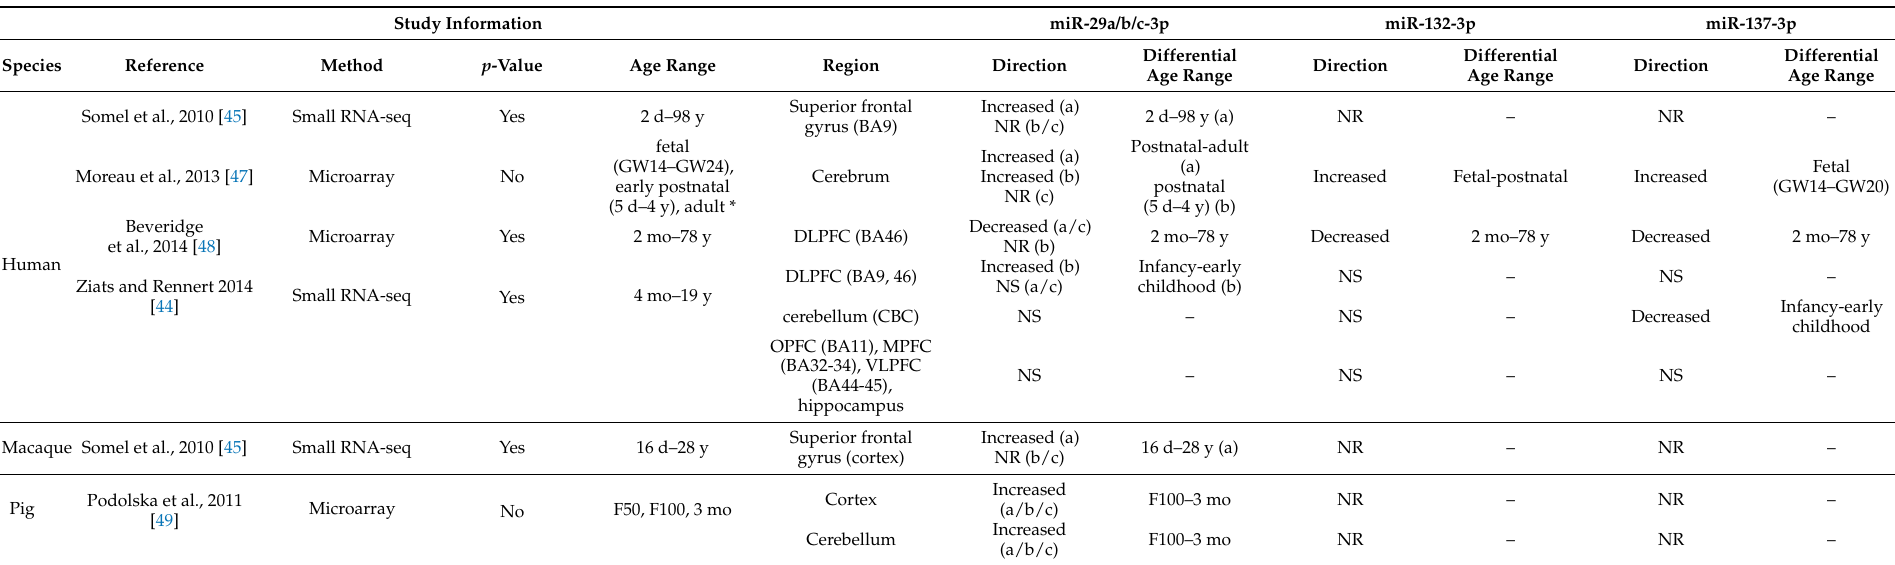
Table 2. Changes in specific miRNAs with age in primate and pig